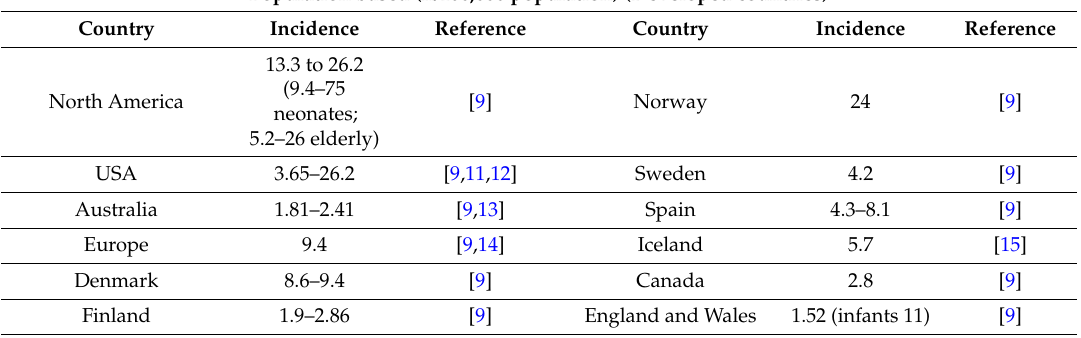
Table 1. Country-wise incidence of